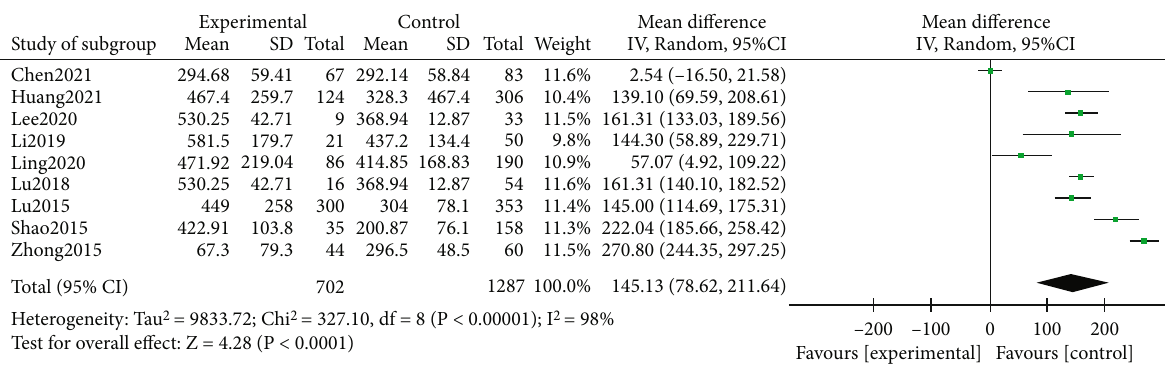
Figure 3: Estimated MD summary for LDH.